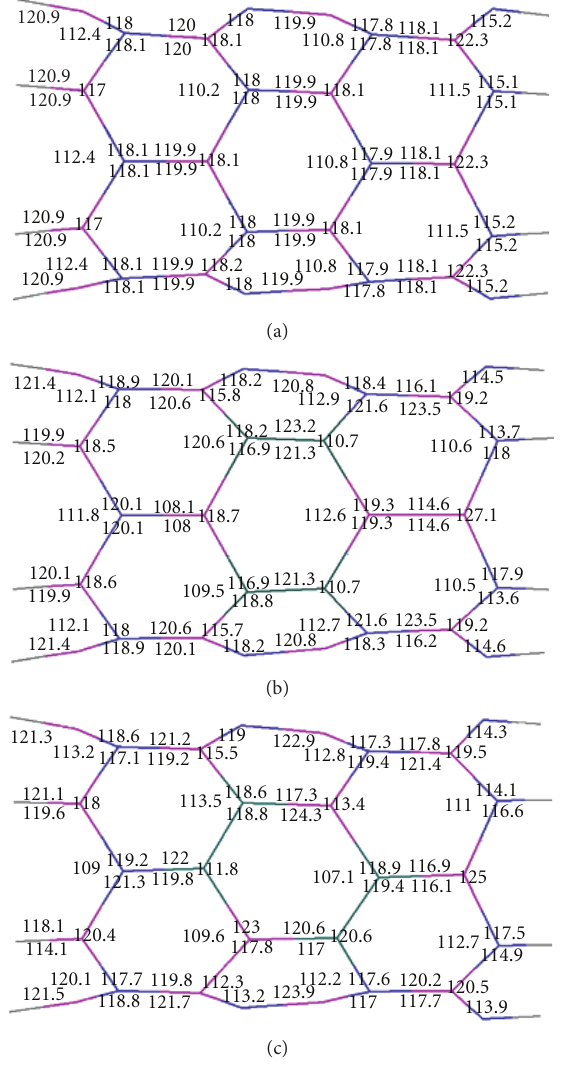
(c) ) at B3LYP/6-311G ○